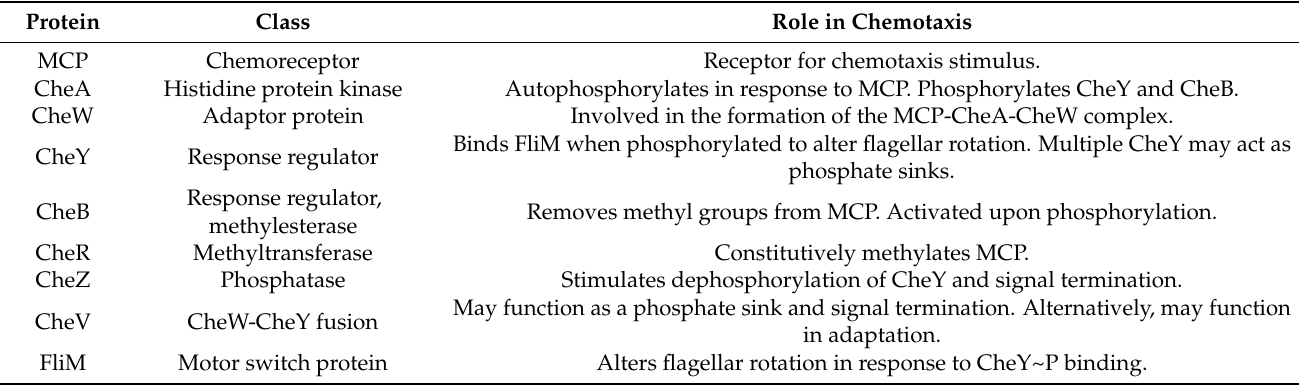
Table 1. Classification and function of the middle components of chemotaxis signalling pathways.